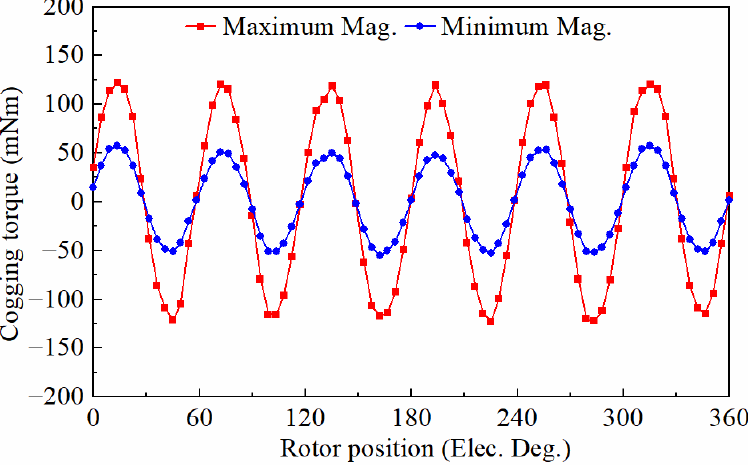
Figure 12. Torque waveforms in the maximum and minimum magnetization states.